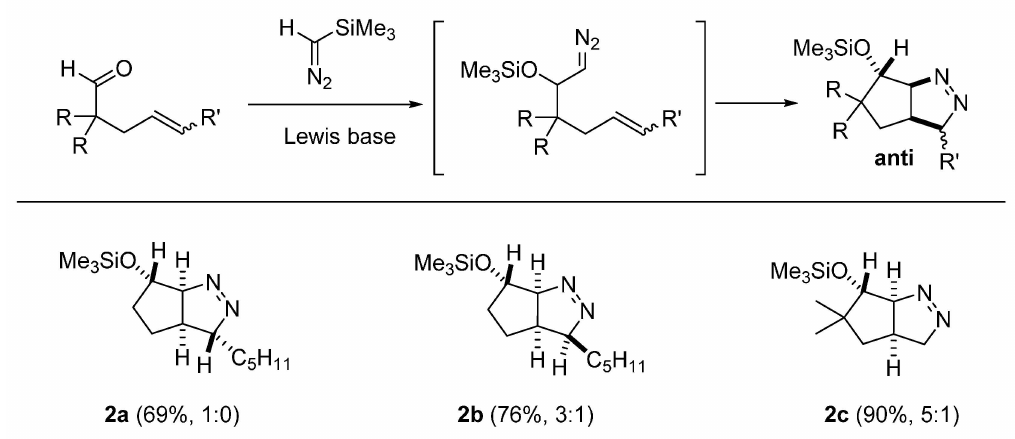
Figure 6. Tandem reaction of TMSD with 4-alkenyl aldehydes with high anti